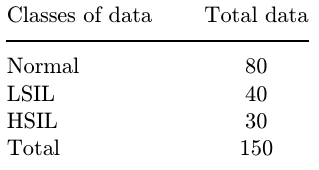
Table 1. Data descriptions to test screening system. Classes of